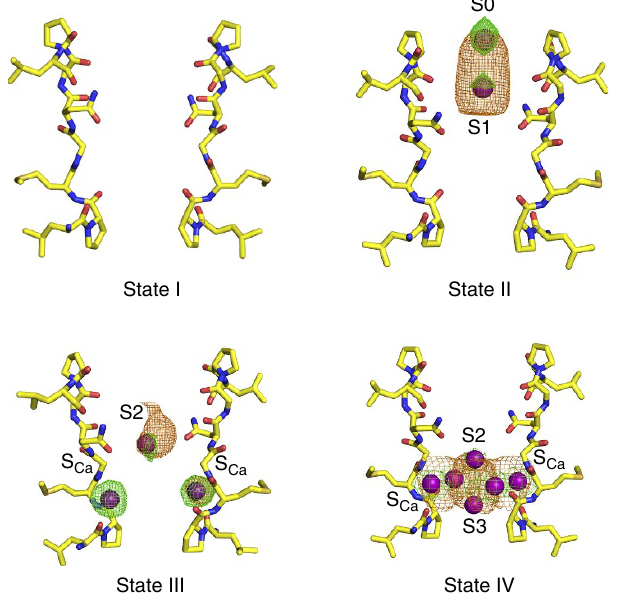
Figure 4 | Occupancy states of the selectivity filter of NaKTs. Snapshots of the selectivity filter of the NaKTs ion channel structure (yellow sticks), describing the location of Ca 2 þ ions along the ion-conduction pathway, categorized into four different states. Selectivity filter of state I is seen in three tetramers (chain CGHI of datasets 1 and 3 and chain FJKL of dataset 1), selectivity filter of state II is seen in one tetramer (chain FJKL of dataset 3), selectivity filter of state III is seen in 2 tetramers (chain ABDE of datasets 1 and 2), selectivity filter of state IV is seen in two tetramers (chain ABDE of dataset 3 and chain FJKL of dataset 2). Calcium ions are shown as purple spheres, along with their respective anomalous density maps (orange) at 5–10 s contour and F o (cid:2) F c map (green) at 4 s contour.